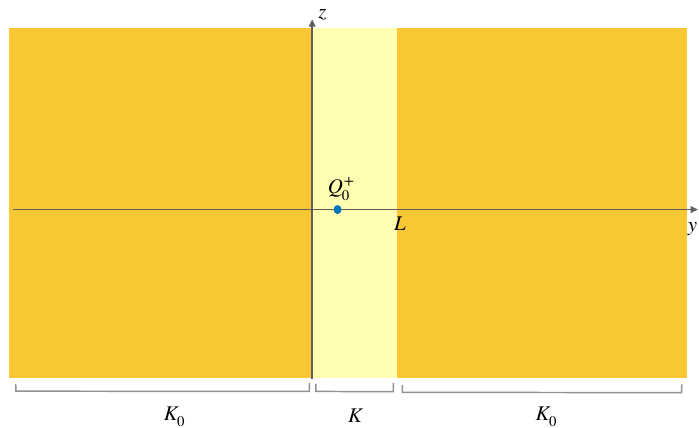
Figure 1: Space-time representation of a piecewise-homogeneous 2D gaussian free field (7) with alternating value of the coupling parameter, K the propagator of the theory is equivalent to finding the potential generated by a = 1 within a material characterized by dielectric constant 1 unit charge Q + 0 strip) surrounded by a material with different dielectric constant 1 π quench problem (Sec. 4), z = x is the spatial direction, while y = τ is the (imaginary) time direction. In the problem of a TLL coupled to leads (Sec. 6), instead, the role of the coordinates is